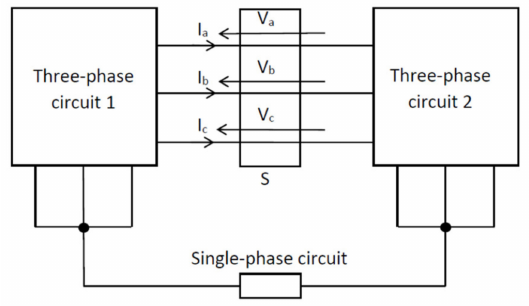
Figure 2. A generic three-phase circuit including a single-phase circuit connected to the star centers. The three-phase port S is where asymmetrical line switching is operated.